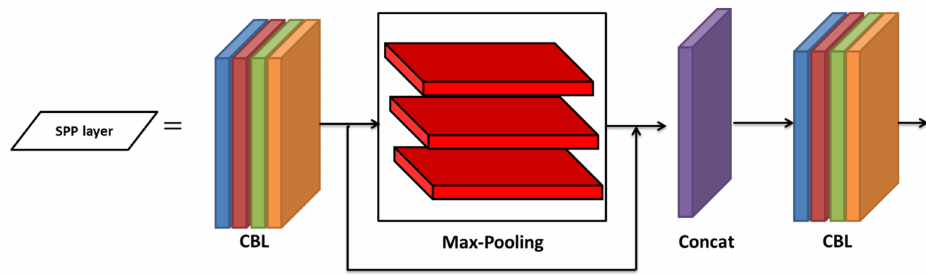
Figure 9. Architecture of the SPP layer module.